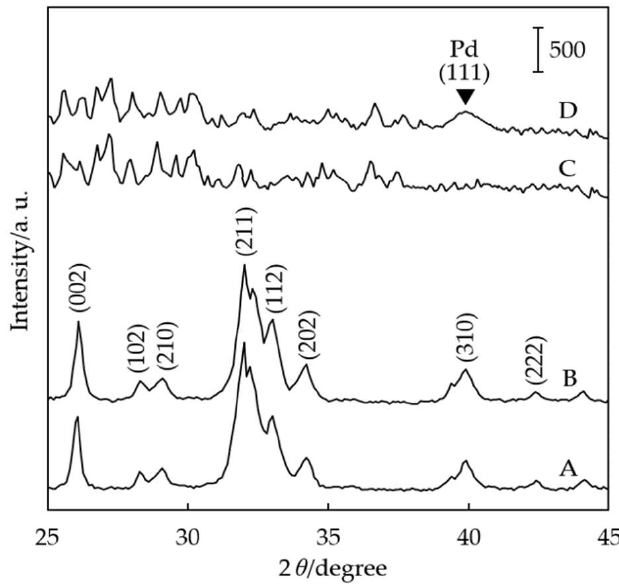
Figure 5. XRD patterns of Pd-PW-HAP and Pd+PW 2 before and after reaction. (A): Pd-PW-HAP before reaction; (B): Pd-PW-HAP after reaction at 363 K for 8 h; (C): Pd+PW 2 before reaction; (D): Pd+PW 2 after reaction at 363 K for 8 h.